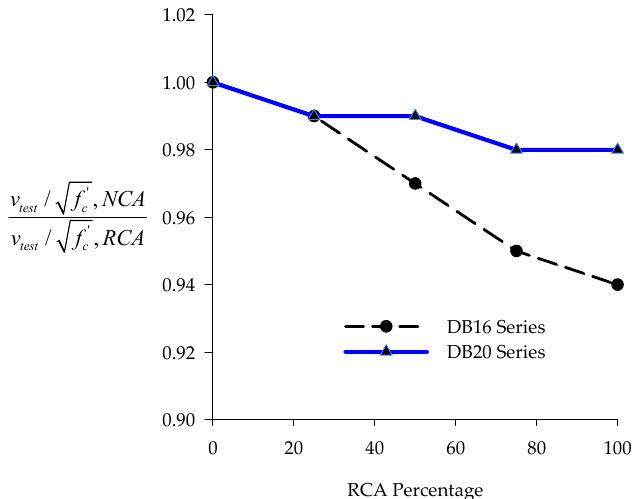
Figure 6. The ratio of normalized shear stress between RAC and NAC beams with different amounts of RCA.